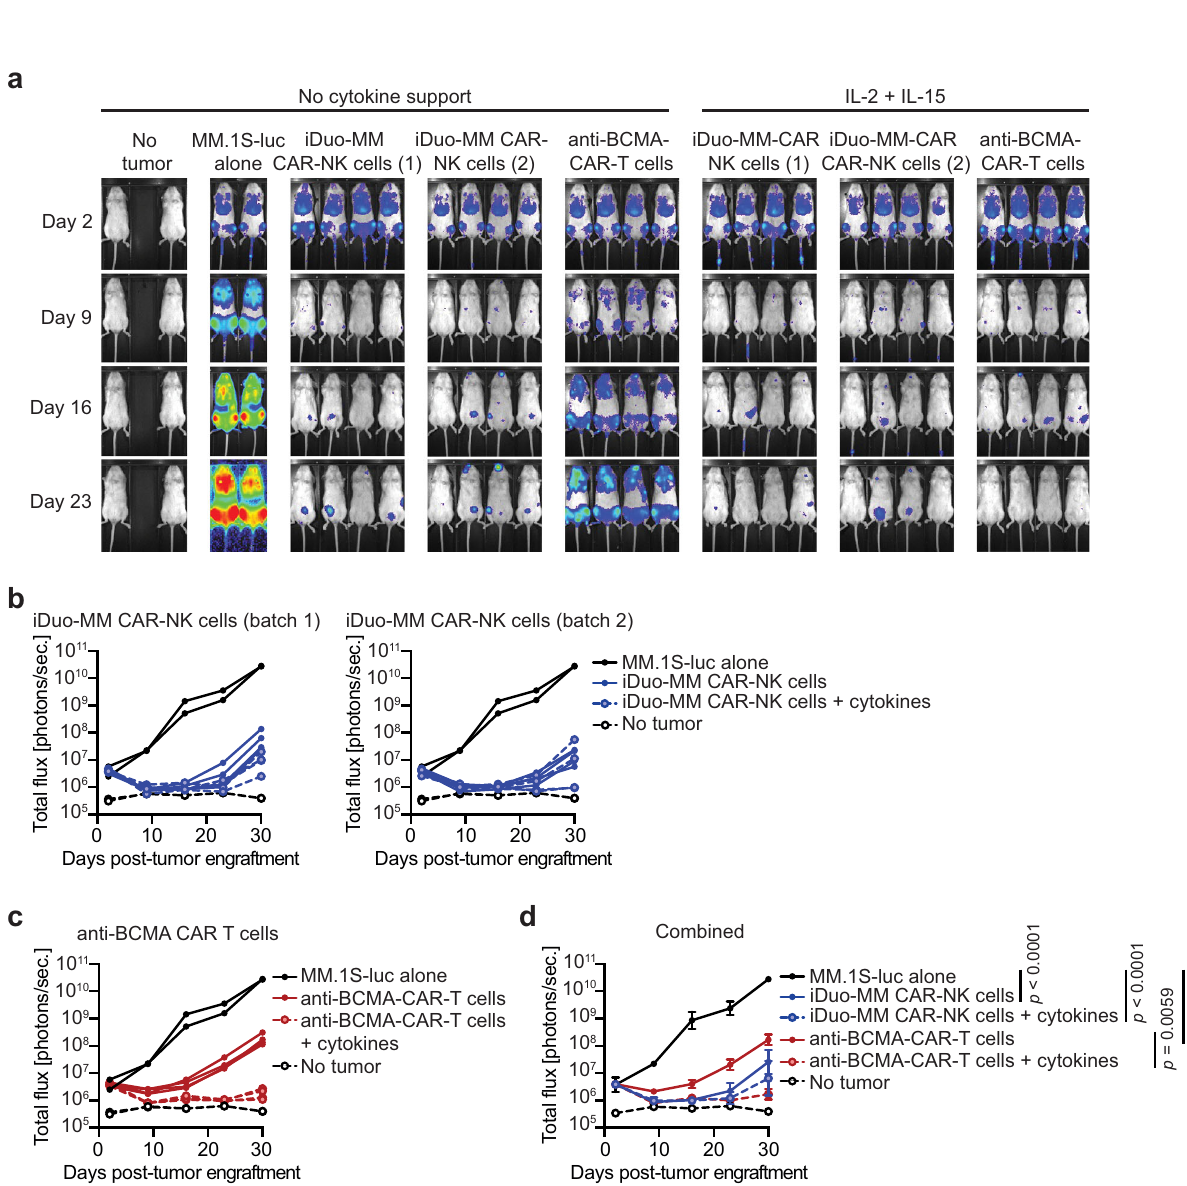
peripheral blood in the single effector dose experiments. e Graphical representa- tion of the bioluminescence data for the multiple effector dose arm of the study. f AnalysisofhumanNKcellcountsintheperipheralbloodforthemultipleeffector dosearmofthestudy. g Representative fl owcytometryplotsforanalysisofmouse peripheral blood in the multiple effector dose experiments. Statistical signi fi cance was determined by two-way ANOVA. All graphed data are presented mean values±SD. Source data are provided as a Source Data fi le.